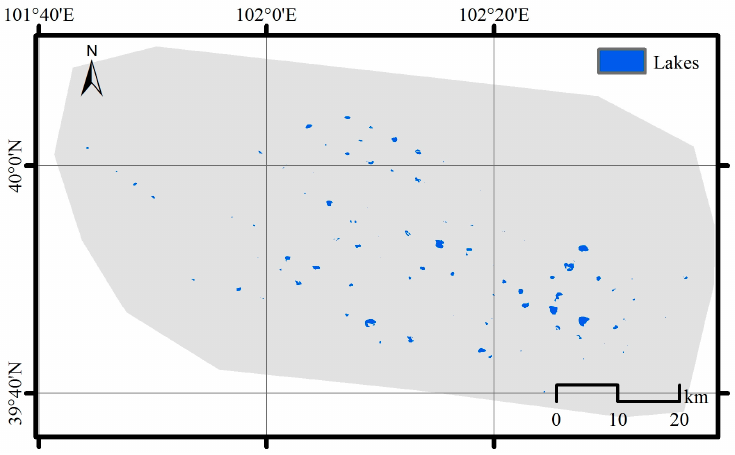
Figure 2. Lakes extent in the BJD retrieved from Landsat images in 24 July 2002 by using the AWEI sh index.